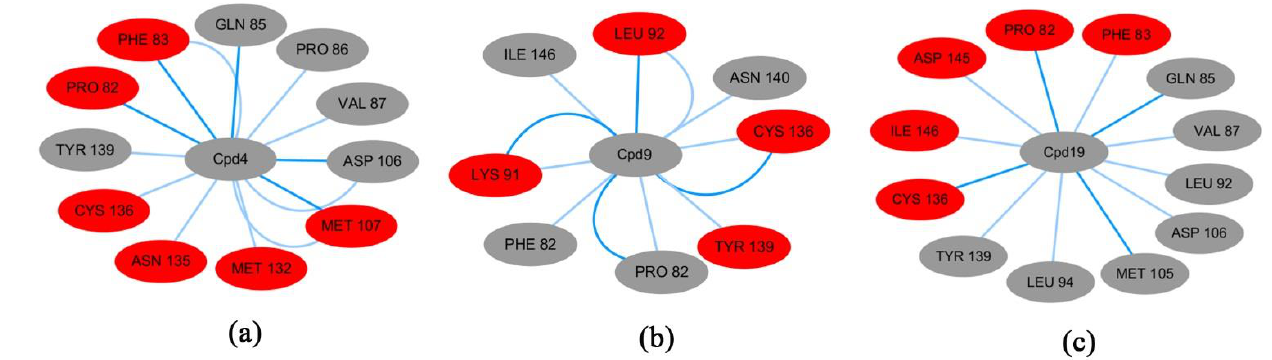
Figure 9. Subnetwork analysis of the protein − ligand interaction. ( a ) Subnetwork betweenBRD4 and Cpd4; ( b ) subnetwork between BRD4 and Cpd9; ( c ) subnetwork between BRD4 and Cpd19. Table 3. MM-GBSA results (kcal/mol).